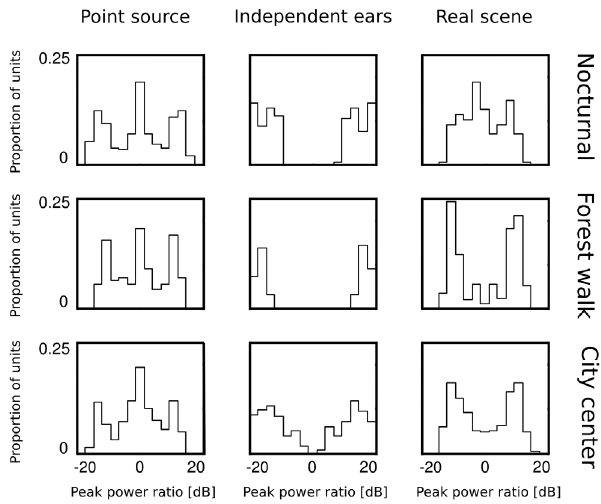
Figure 12. Distributions of peak power ratios of independent components trained on simulated and natural sounds. Columns correspond to datasets (point source, independent ears, natural scene) and rows to recorded environments (nocturnal nature, forest walk, city center). Simulated data gave rise to stereotypical and repetitive PPR distributions. Natural scenes, while being a compromise between simulated environments, were more similar to the independent ear